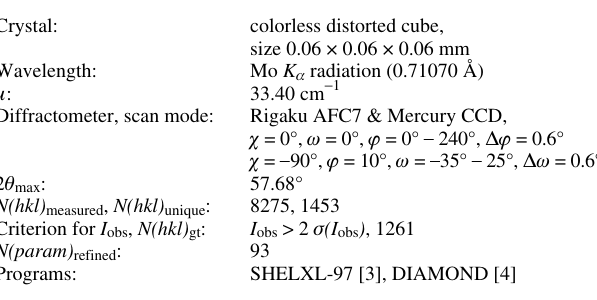
Table 1. Data collection and